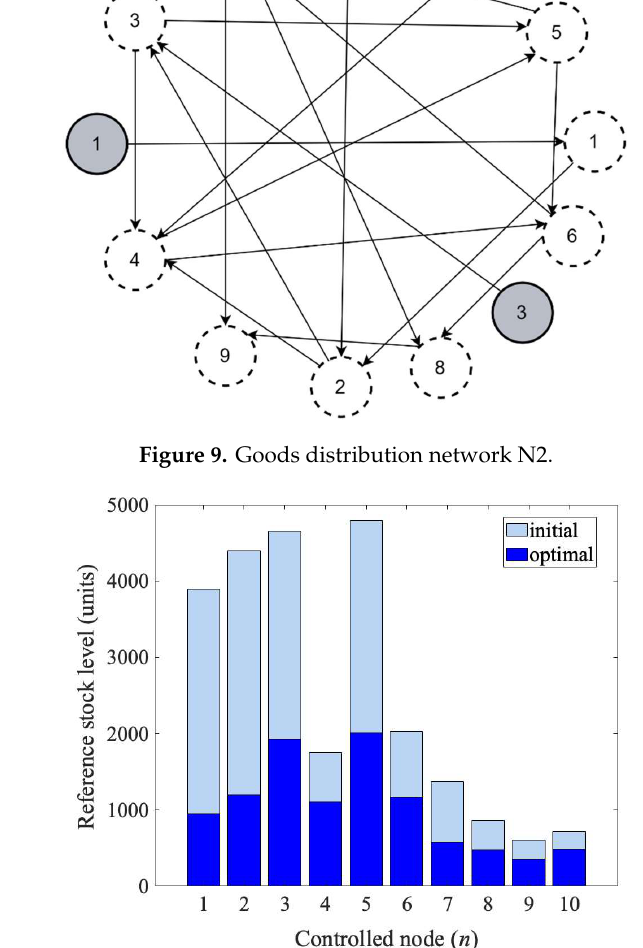
Figure 11. Fill rate vs. holding costs trade-off for network N2. These observations are quite general. As was investigated for different network sizes and structural complexities, the cost-related benefits of the NOUT policy relative to the standard one grew for larger and more intricate topologies. Figure 12 summarizes the policy performances under different fill rate requirements. The bars represent three different topologies, involving three, four, and five supply nodes connected to each controlled node, respectively. The stacked bars reflect the overall holding cost for full (100%) and high (90%) customer satisfaction levels. As expected, the holding costs decreased when relaxing the fill rate objective. The gain from using the centralized policy relative to the standard one grew for more complex topologies. Interestingly, the holding costs decreased for more involved connectivity structures. This was probably caused by an averaging effect, i.e., although encompassing more nodes and having a denser linkage structure, the topology became more regular with respect to the connection specifics, e.g., the mean lead-time delay for a given node.